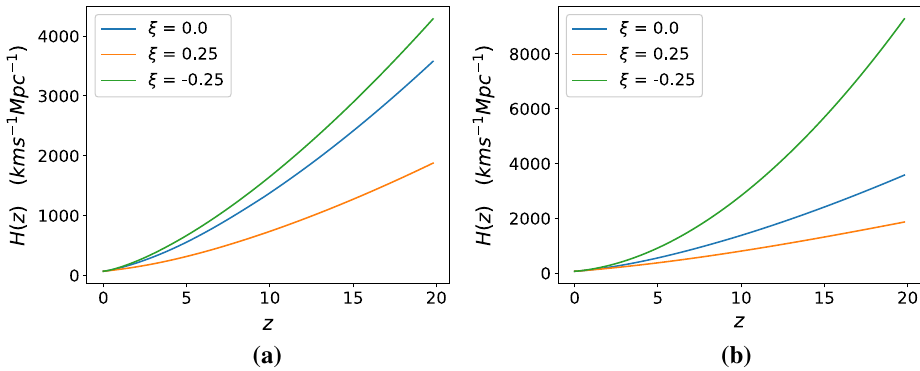
Fig. 1 Hubble parameter as a function of redshift for different values of the interaction. a Model proportional to the energy density of DE, Q = 3 H ξ 2 ρ d . b Model proportional to the energy density of DM, Q = 3 H ξ 1 ρ